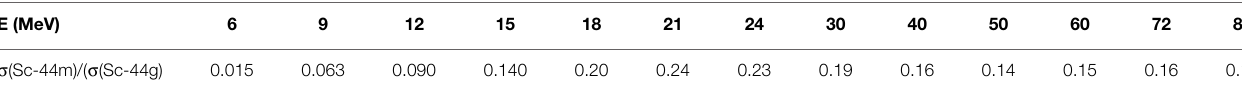
TABLE 2 | Evolution of the cross-section ratio as a function of the proton incident energy (10) .